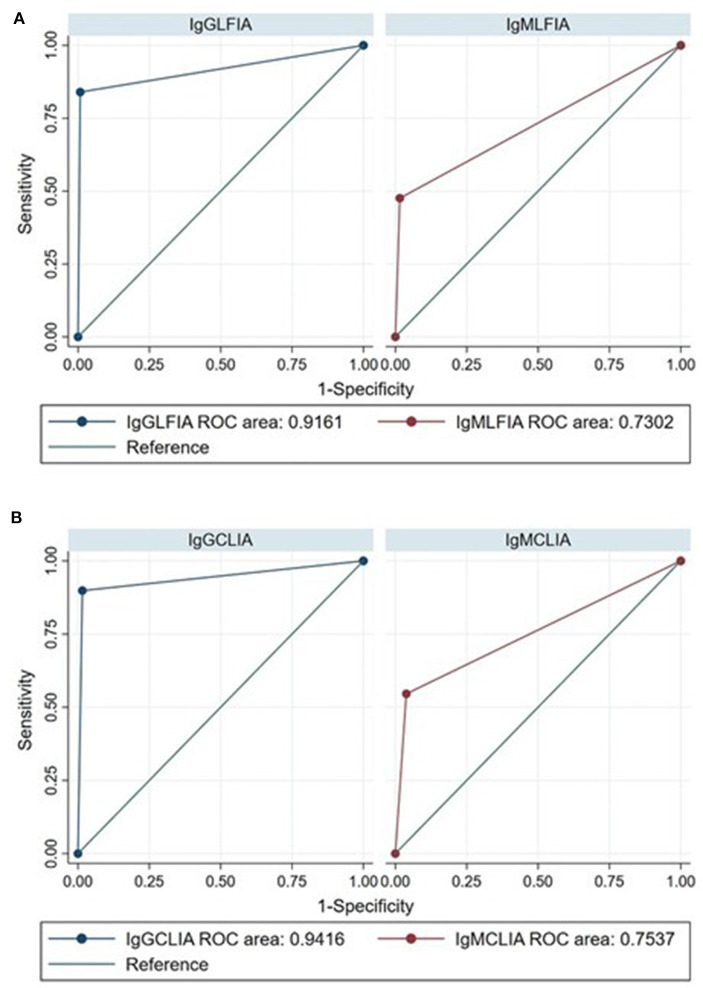
Receiver operating characteristic (ROC) curves for the diagnosis of SARS-CoV-2 infection by IgG and IgM LFIA (A) and CLIA-iFlash (B) using RT-PCR as reference standard ROC area IgG vs. IgM LFIA, p < 0.0001; ROC area IgG vs. IgM CLIA-iFlash, p < 0.0001.